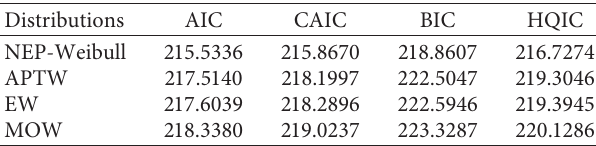
Table 3: The AIC, CAIC, BIC, and HQIC of the fitted models to the life span of the WSNs